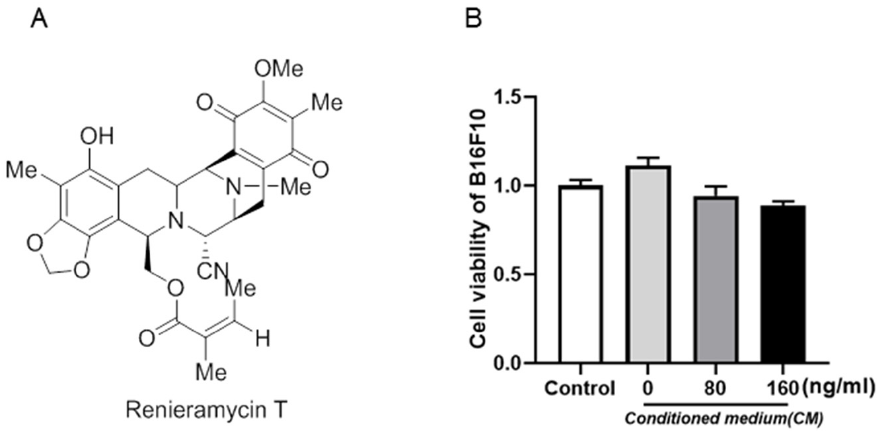
Figure 1. The structure and proliferation effects of renieramycin T (RT) were shown. ( A ) The structure of renieramycin T (RT) is shown. ( B ) RT had no effect on cell proliferation of B16F10 cells in the microenvironment.